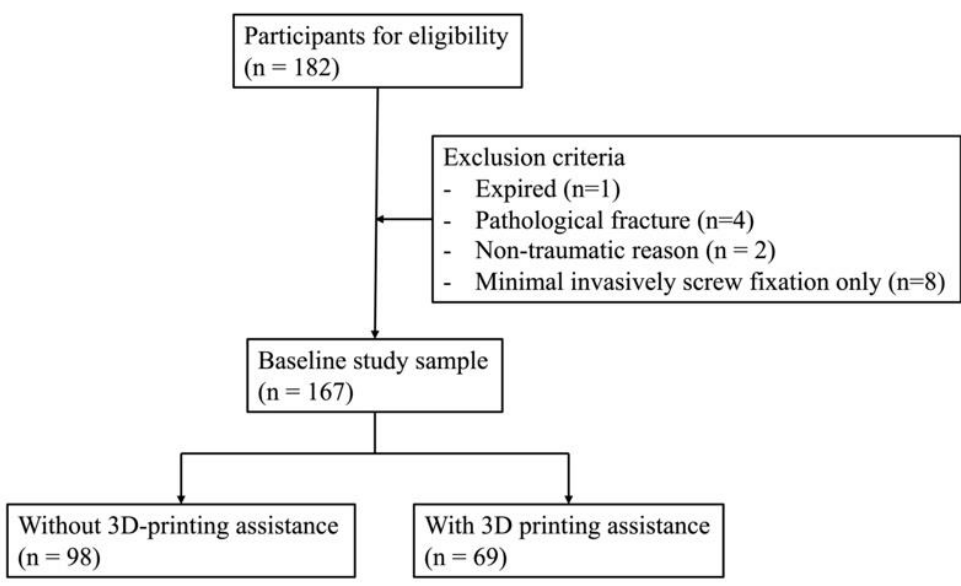
Figure 1. Study Figure 1. Study flowchart.